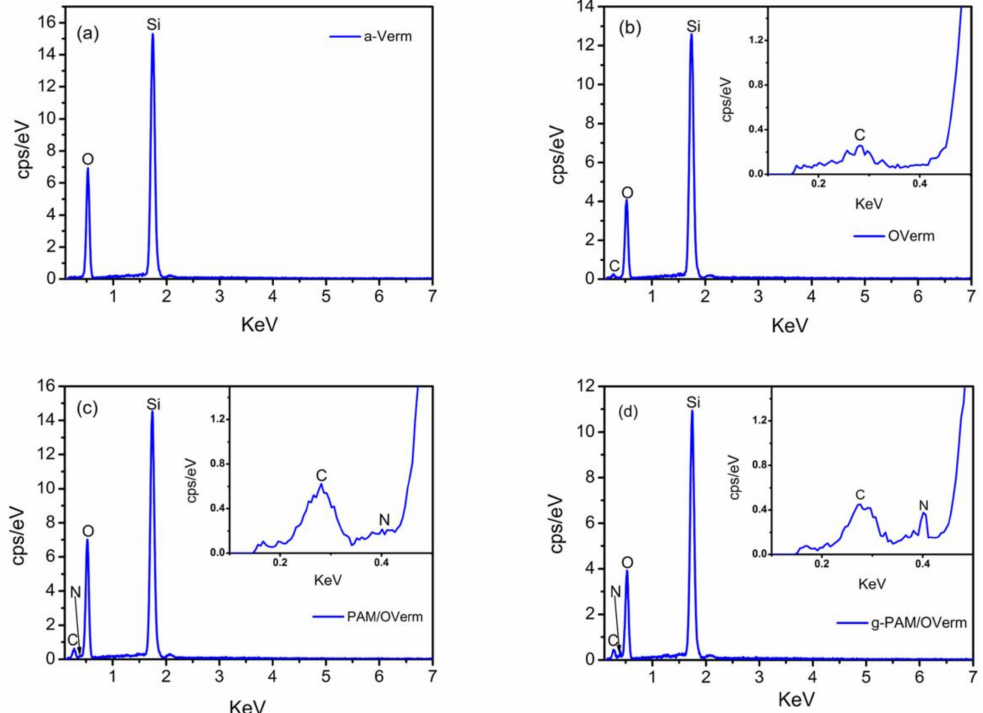
Figure 6. Energy dispersive spectrometer (EDS) patterns of ( a ) a-Verm; ( b ) OVerm; ( c ) PAM/OVerm; ( d )